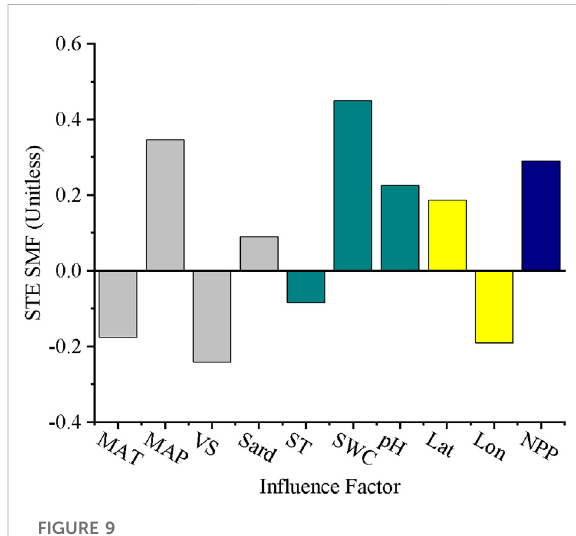
FIGURE 9 The normalized total effects (direct and indirect effects) derived from structural equation modeling